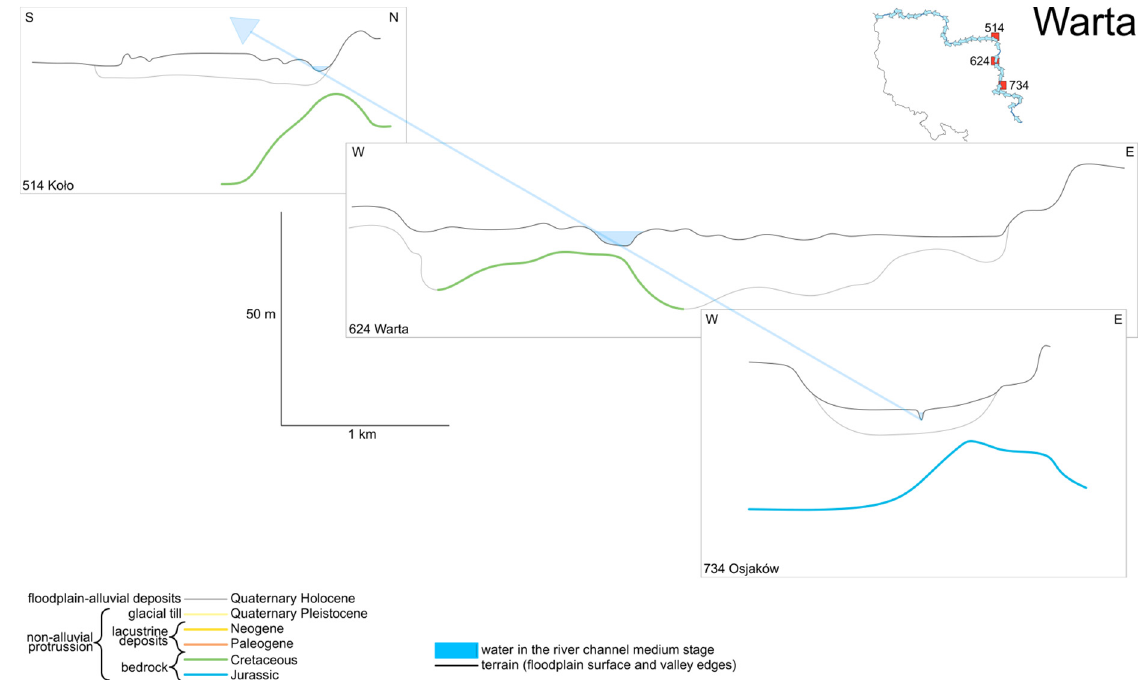
Water 2021 , 13 , x FOR PEER REVIEW Figure 5. Geological cross-sections through the Warta river valley, according to [59–61]. Each cross-section presents: water in the river channel during medium stage (blue body); schematic river channel with flow direction (blue line) the valley profile graph with the floodplain surface and the valley’s walls (black), alluvial cover of the floodplain (grey) and non-alluvial protrusion underneath. The color of the non-alluvial protrusion indicates its age according to the stratigraphic chart [43].